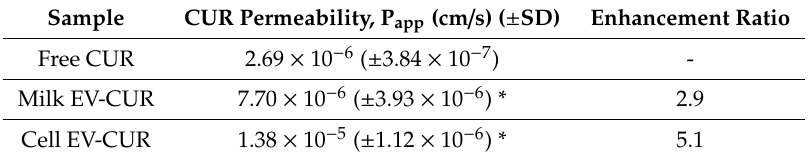
Table 2. Permeability of curcumin (CUR) and CUR incorporated into milk-derived and Caco-2 cell-derived extracellular vesicles (‘Milk EV-CUR’ and ‘Caco-2 EV-CUR’, respectively). Permeability was tested over fourh, with regular sampling of the basolateral solution and CUR quantitation by absorbance. Permeability expressed as apparent permeability coe ffi cient (P app ). Data shown as